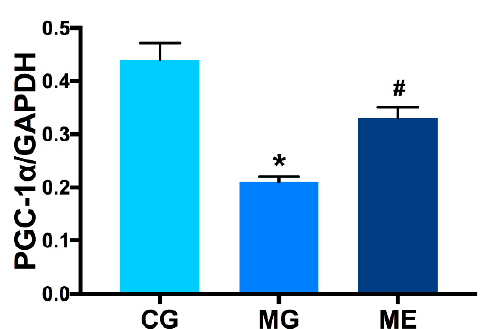
Figure 3. Protein: PGC-1 α , Internal reference protein: GAPDH. Control Group = CG, Model Group = MG, and Model Exercise Group = ME; * indicates p < 0.01 compared with CG; # indicates p < 0.01 compared to MG.